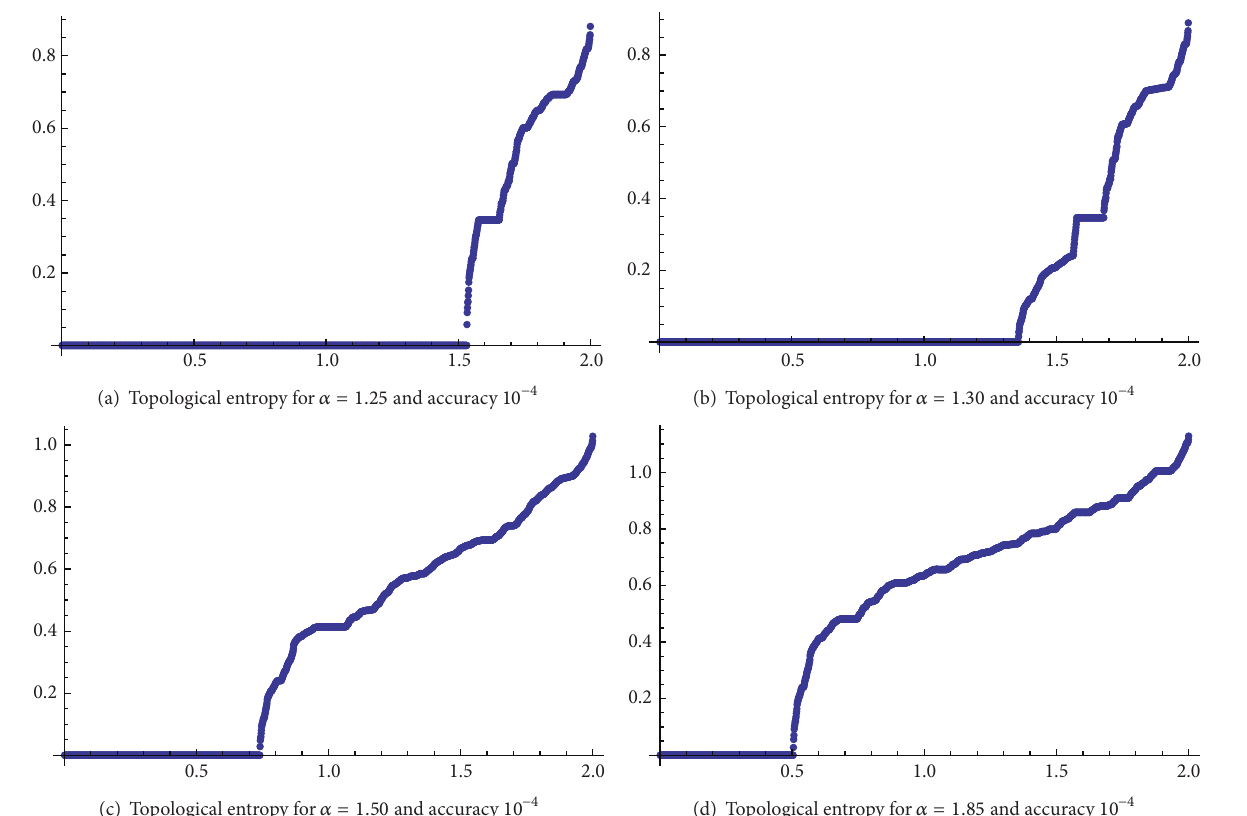
Figure 5: Topological entropy for different fixed 𝛼 while 𝛽 ∈ [0,2]